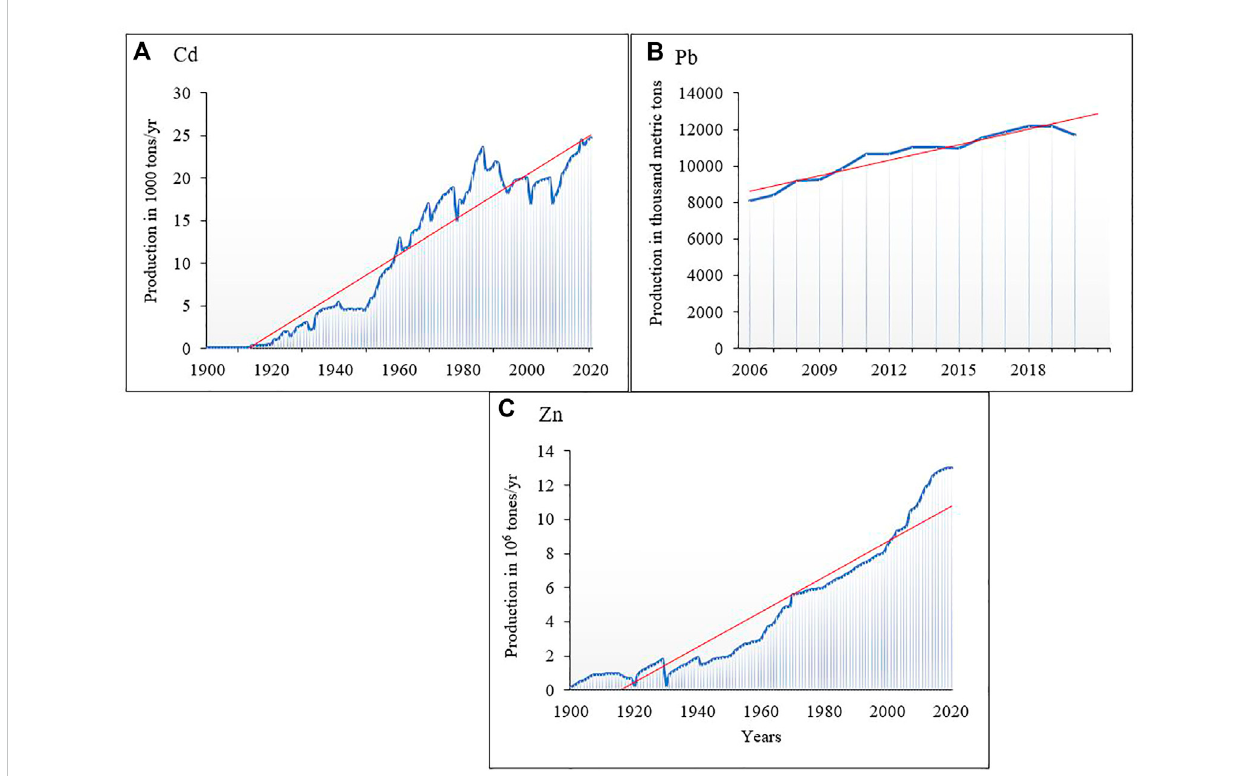
FIGURE 1 World production trend of (A) As, (B) Cd (adopted from Lucía Fernández, 2022, (C) Pb (Statista Research Department), and (D) Zn (U.S. Geological Survey,